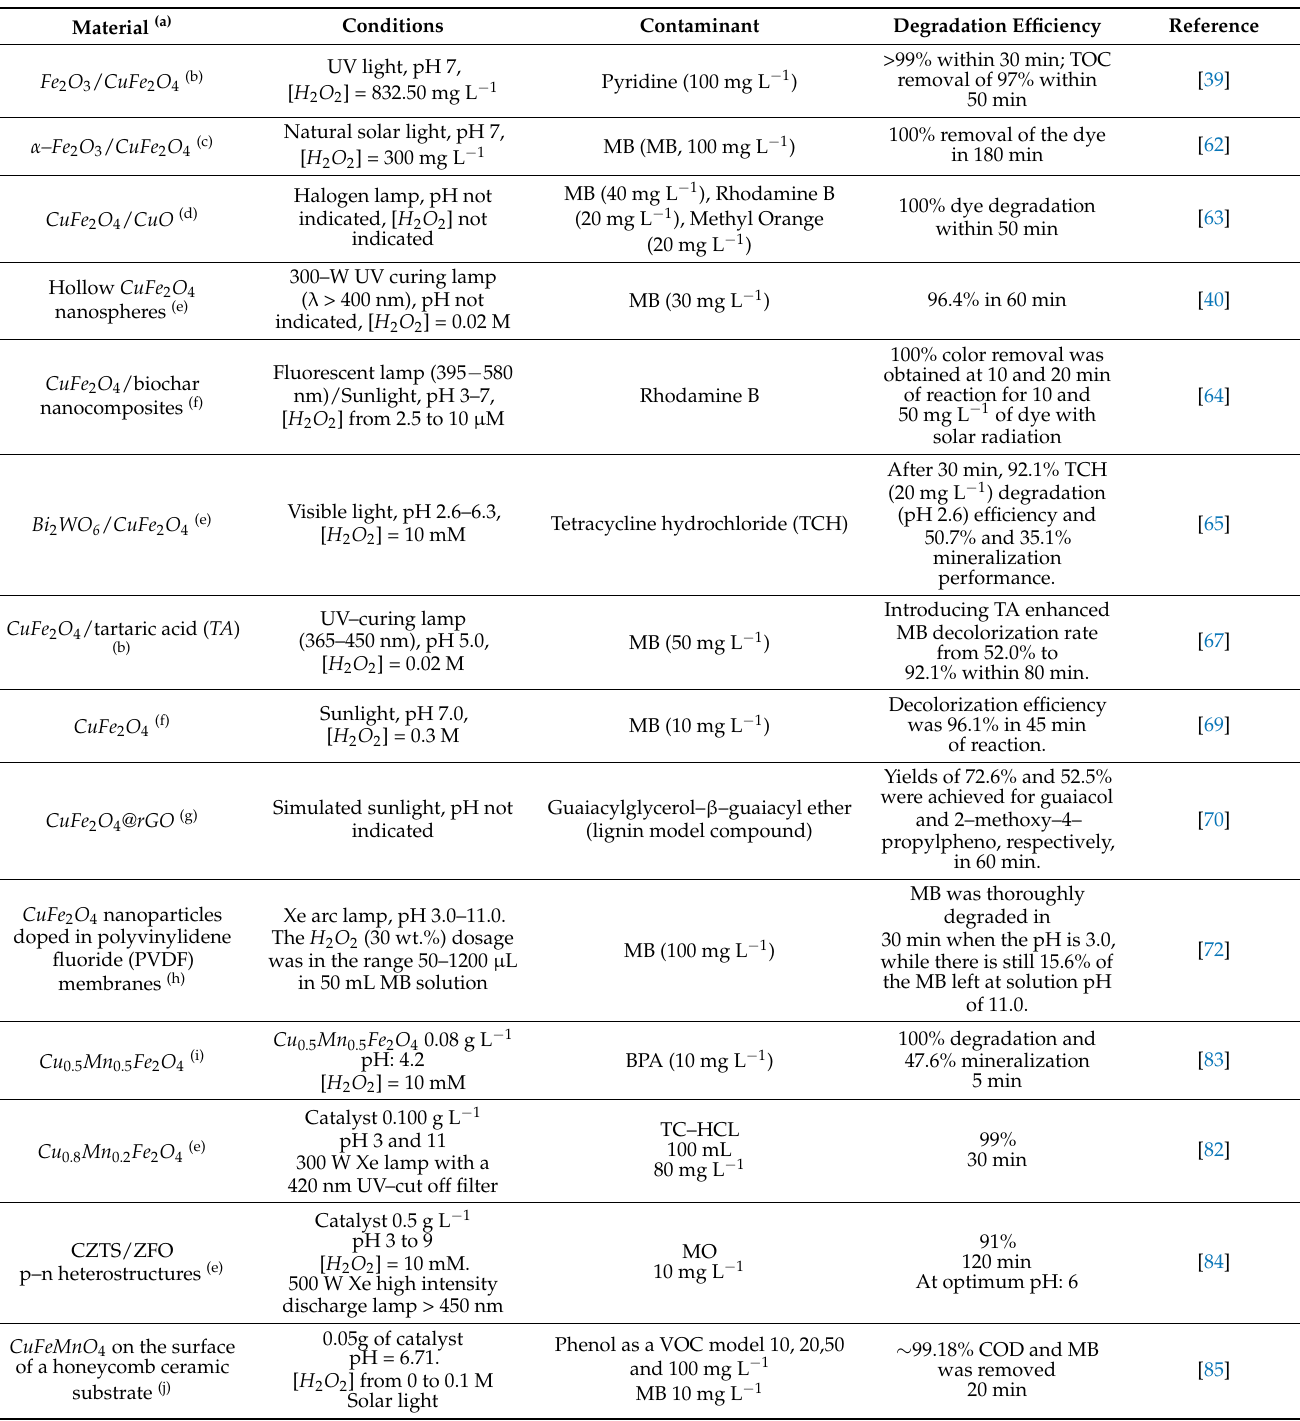
Table 1. Summary of recently used Fe–Cu ferrites and mixed ferrites as photo–Fenton photocatalysts in wastewater